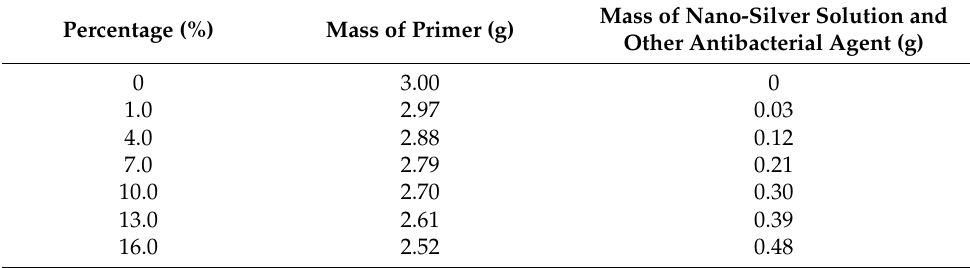
Table 2. Composition of antibacterial